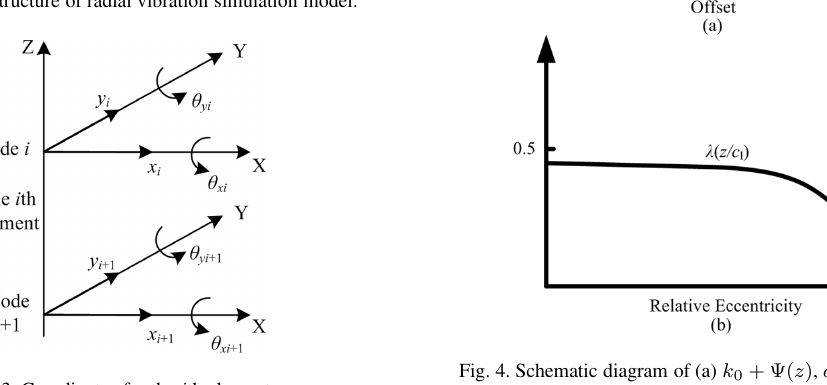
Fig. 3. Coordinates for the i th element.